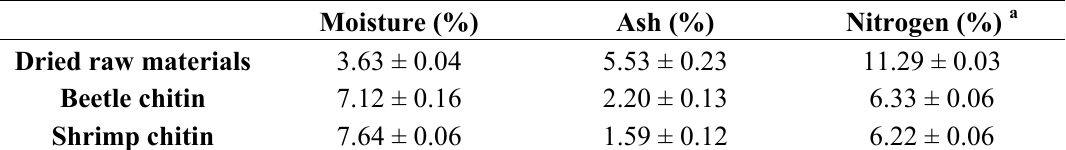
Table 1. Chemical composition of dried raw materials and chitin from adult H. parallela and shrimp chitin.